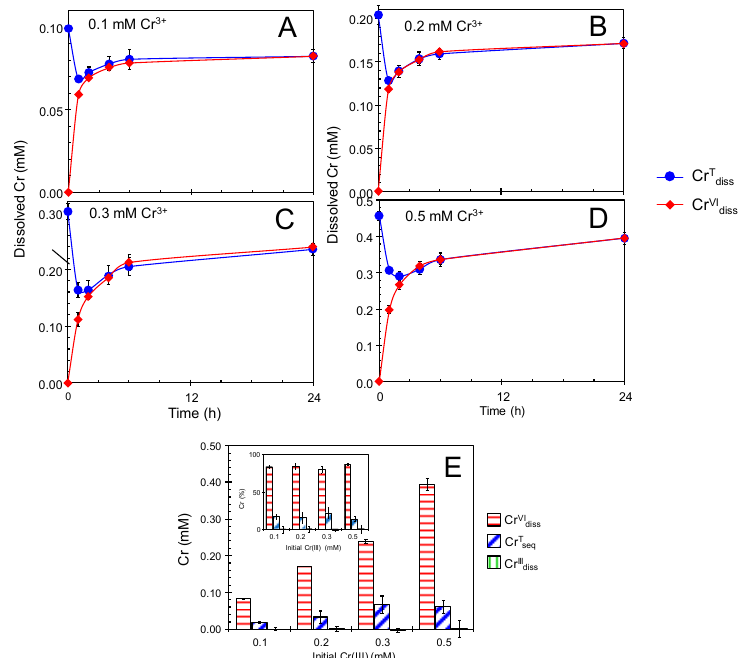
Figure 1. Single treatment of newly formed biogenic manganese oxides (BMOs; 1 mM as Mn) with 0.1–0.5 mM Cr(NO 3 ) 3 under aerobic conditions at pH 6.0 (100 mM morpholinoethanesulfonic acid